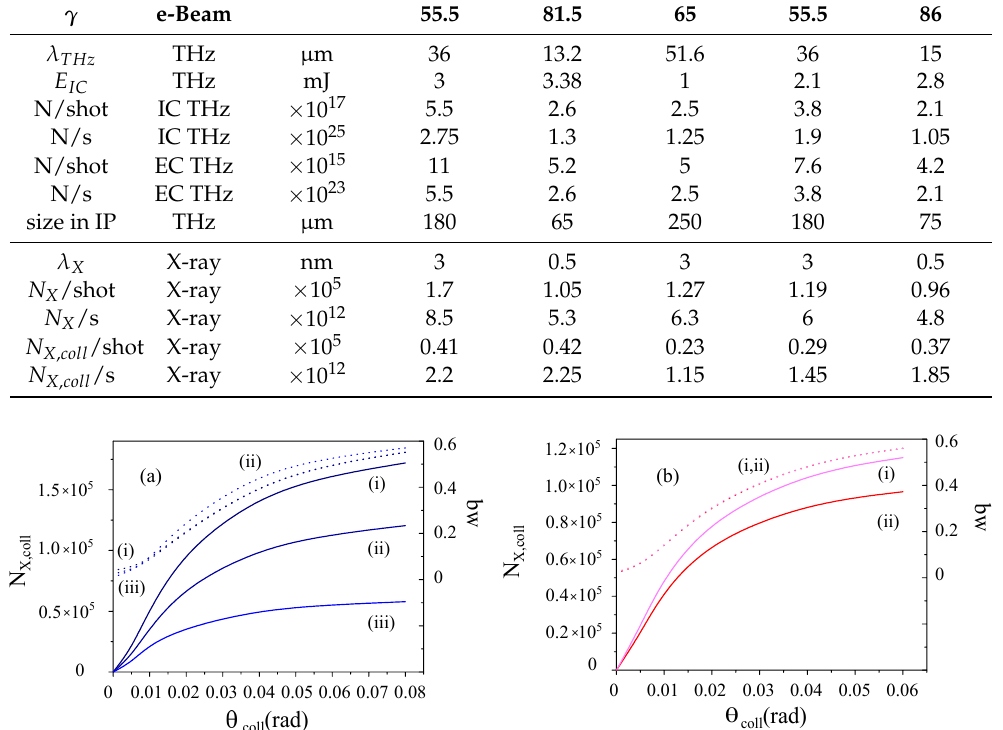
Figure 12. Number of photons N X , coll (solid lines) and bandwidth (dotted lines) as a function of collimation angle θ coll (rad). Window ( a ): λ X = 3 nm, (i) λ w = 3.5 cm, λ THz = 36 µ m; (ii) λ w = 4.5 cm, λ THz = 36 µ m; (iii) λ w = 4.5 cm, λ THz = 51.6 µ m. Window ( b ): λ X = 0.5 nm, (i) λ w = 3.5 cm, λ THz = 13.2 µ m; (ii) λ w = 4.5 cm, λ THz = 15 µ m. In window ( b ), the bandwidths relevant to cases (i) and (ii) are not distinguishable.